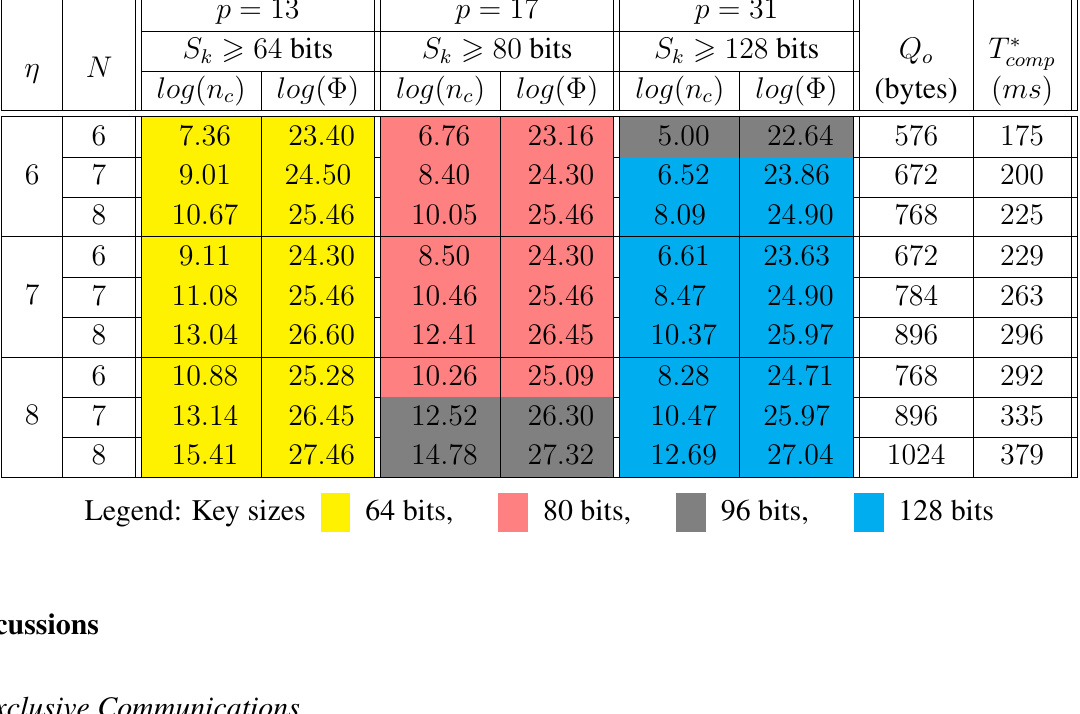
is the pairwise key size, traitor k